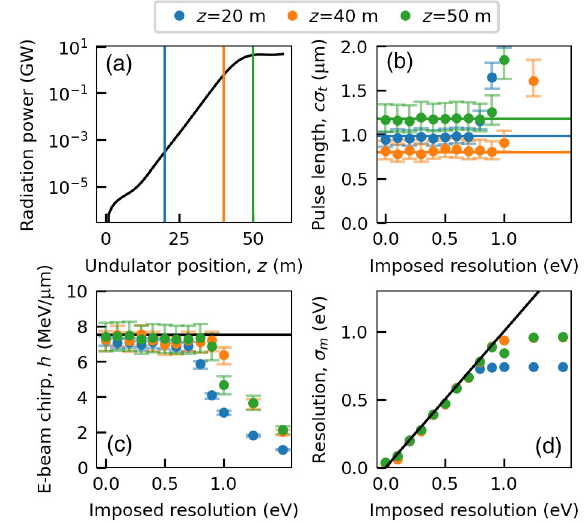
FIG. 4. Results from 1D simulations scanning the spectrometer resolution for a fixed 7 . 5 -MeV = μ m e-beam chirp. (a) shows the average radiation power along the undulator marking z ¼ 20 m (blue), z ¼ 40 m (orange), and z ¼ 50 m (green). (b), (c), and (d) show the reconstructed pulse length, e-beam chirp, and spectrometer resolution as a function of imposed spectrometer resolution at those three